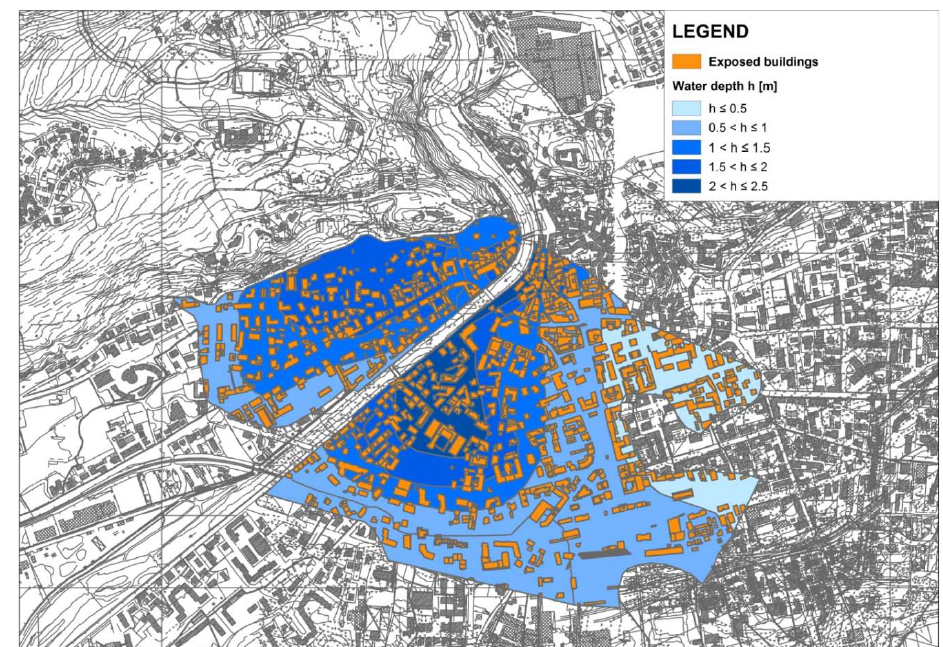
Fig. 4. Sondrio hazard map when Q = 340m 3 s − 1 (adapted from Franzetti, Figure 4. Sondrio hazard map when Q = 340 m 3 /s (Adapted from Franzetti 2005). 2